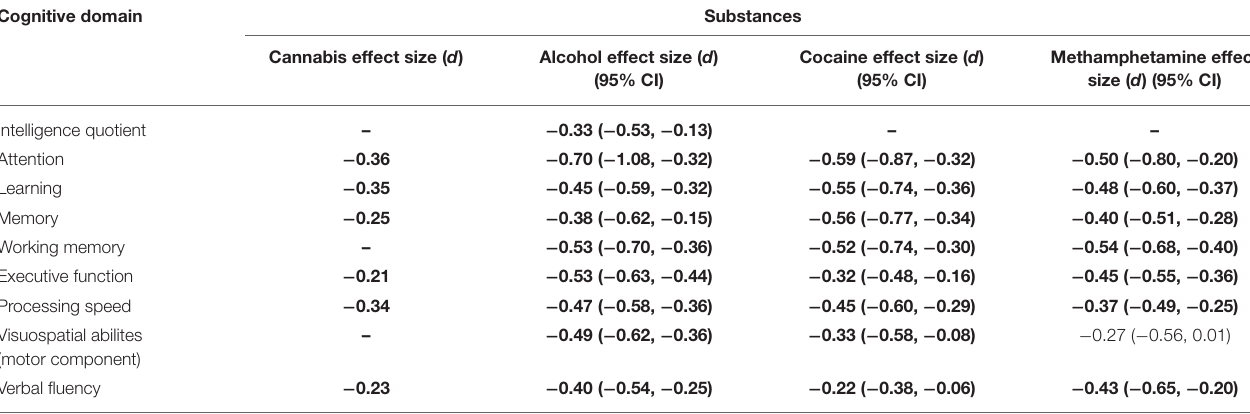
TABLE 2 | Residual effects of cannabis use on cognitive functions in comparison to other substances. Cognitive